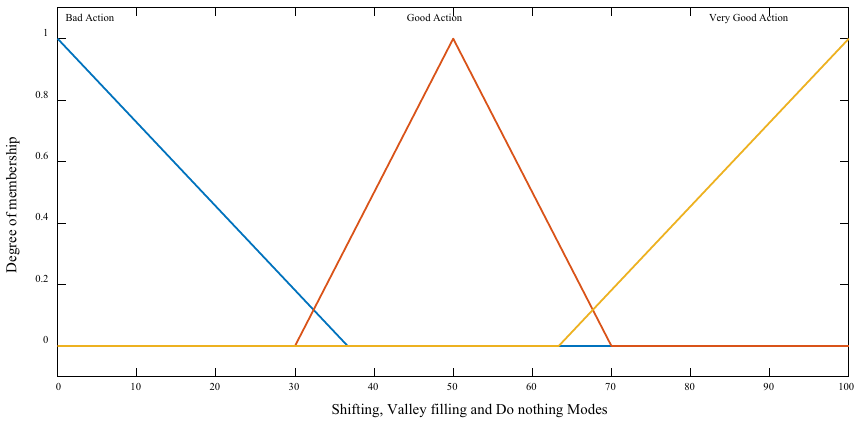
Fig. 3 Smart scheduling fuzzy sets of the output variables